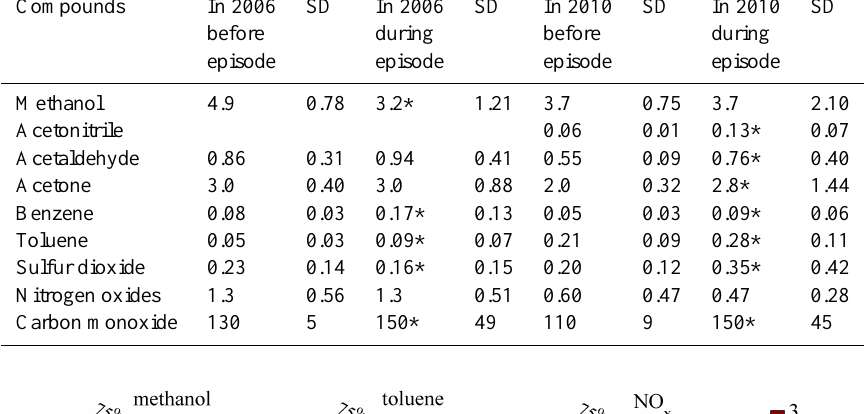
Table 5. Mean VMRs of studied trace gases (ppb v ) and standard deviations (SDs) before and during the forest fire episodes in 2006 and 2010. The VMRs of the compounds were calculated from VMR data which were selected using trajectories from the burning areas. Area 1 is 58–62 ◦ N, 27–36 ◦ E in 2006 and area 2 is 56–61 ◦ N, 28–34 ◦ E in 2010. Asterisk indicates when VMR of a trace gas differs significantly from pre-fire VMR (two-sided t test).